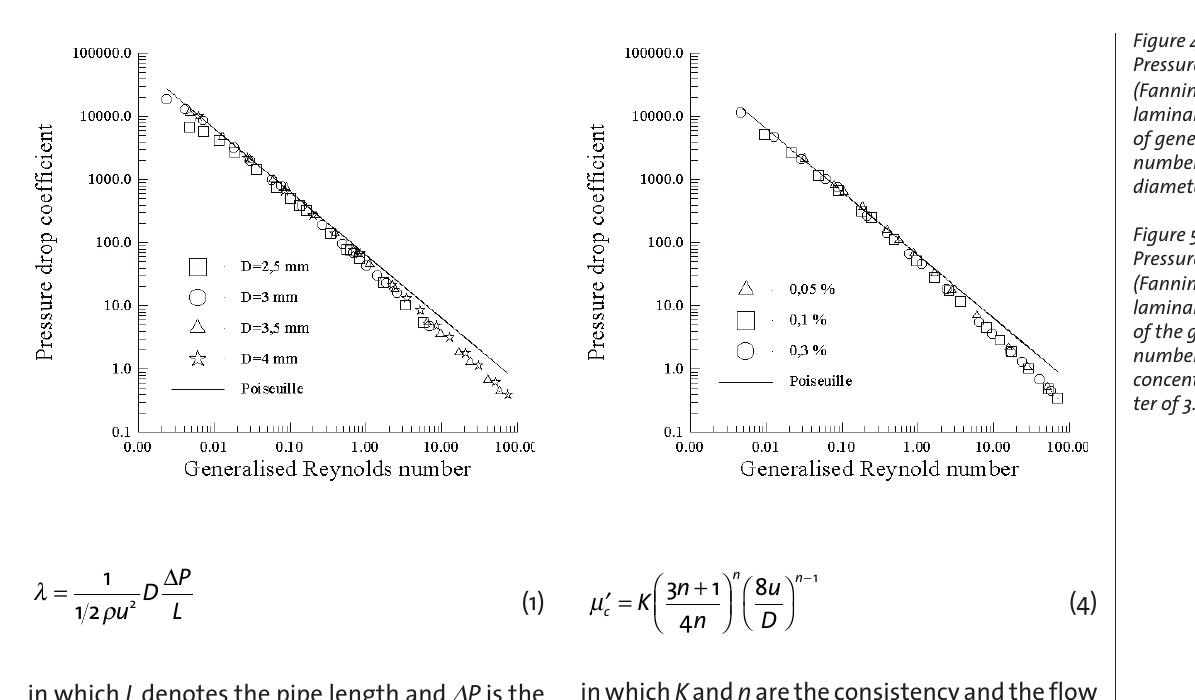
Figure 4 (left): Pressure drop coefficient, λ, (Fanning friction factor) for laminar flow as a function of generalised Reynolds number for different pipe diameters (0.3% PEO foam). Figure 5 (right): Pressure drop coefficient, λ, (Fanning friction factor) for laminar flow as a function of the generalised Reynold number for different PEO concentrations (pipe diame- ter of 3.5